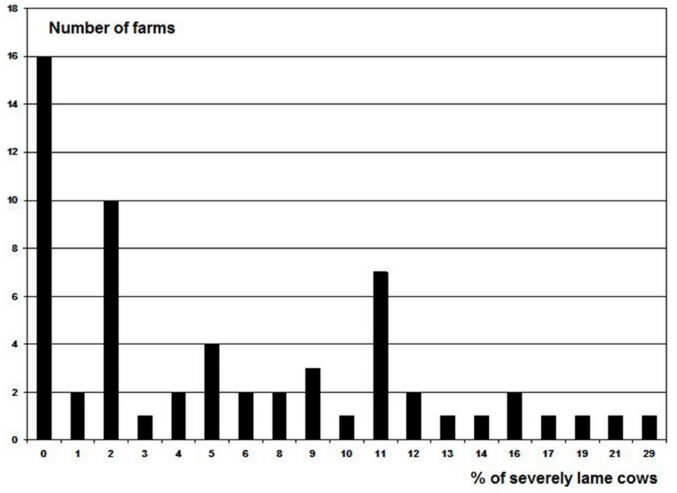
Figure 4. Frequency distribution of the percentage of severely lame cows on the 60 farms.